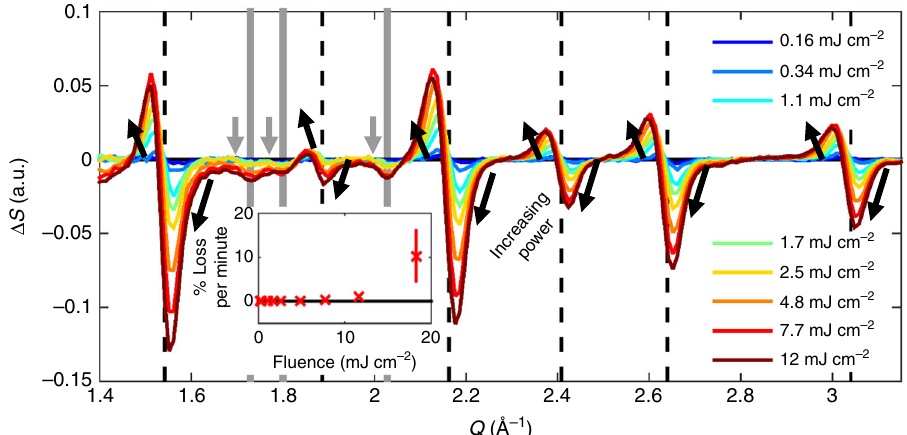
Fig. 4 Fluence dependence of lattice deformation. TR-XRD patterns of CsPbBr 3 NCs 40 ps after photoexcitation at a range of excitation fl uences. The orthorhombic peaks are delineated with gray solid lines and the high-symmetry black dashed. A solid black line also denotes Δ S = 0 and arrows emphasize how the TR-XRD pattern evolves with power. Inset: Irreversible percent loss of peak intensity versus excitation power. The error bar indicates standard deviation in the